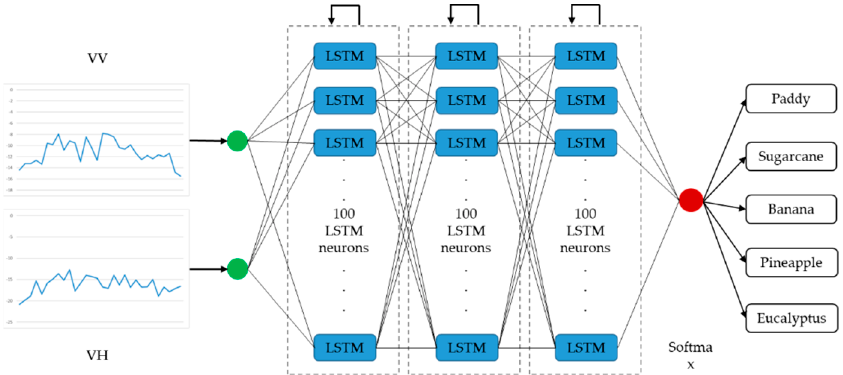
Figure 7. Architecture of the optimal long short-term memory recurrent neural network (many-to-one).